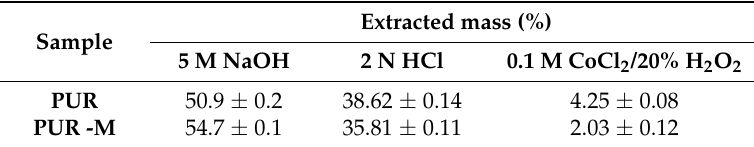
Table 6. The mass loss of the PURs and PURs-M after 15 days of short-term interactions study performed with selected media of the acidic, basic, and oxidative environment.